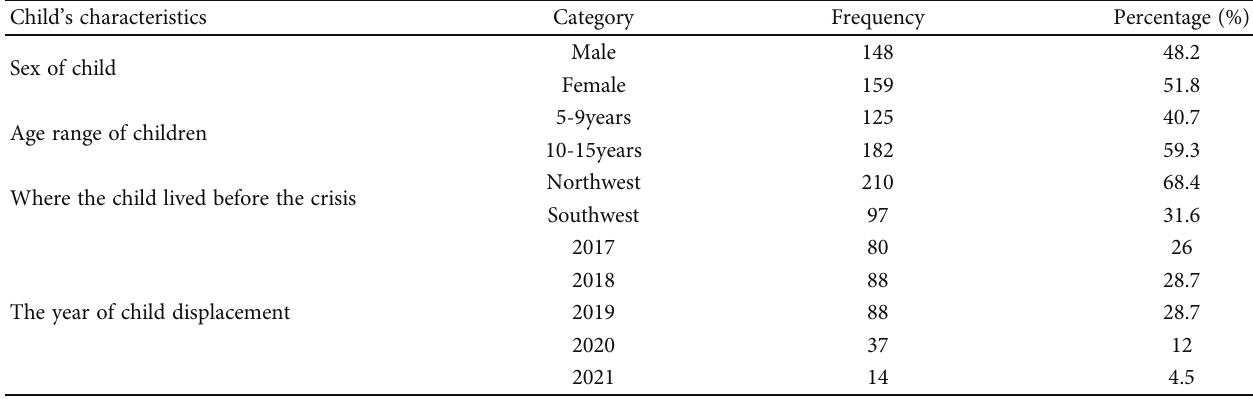
Table 1: Demographic characteristics of the